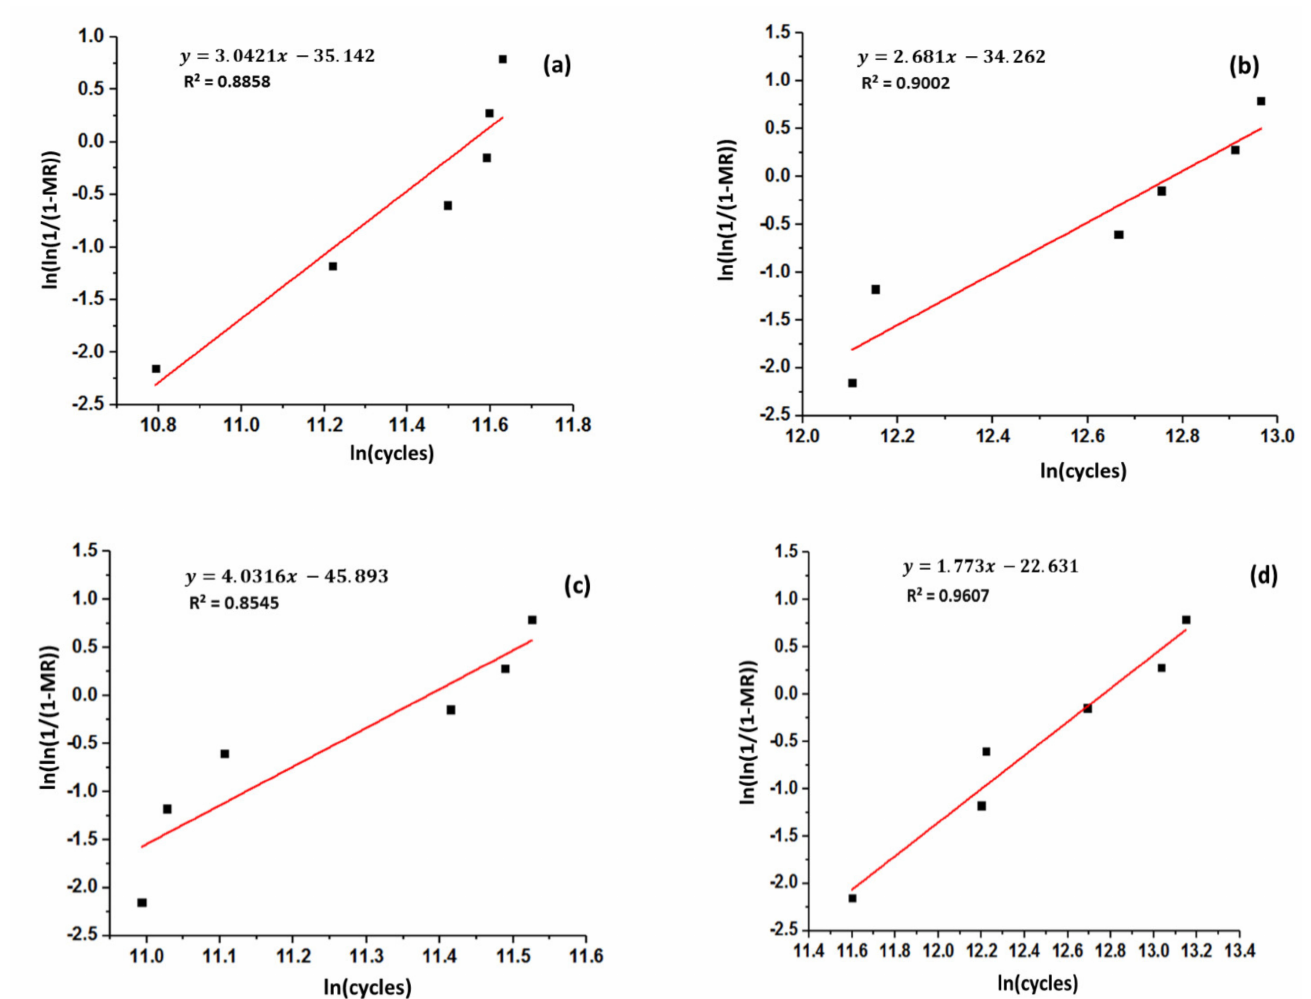
Figure 6. Weibull plots for ( a ) MO, ( b ) MO + PT, ( c ) MO + WS 2 and ( d ) MO+ MoS 2 . The survival probability curve is shown in Figure 7. It can be seen that MO containing PT and MoS 2 exhibited better survival probability compared to WS 2 -dispersed MO and MO without any additives. It is to be noted that even though MoS 2 initially showed a higher survival probability than PT-dispersed MO, at about 388,000 cycles the situation changed, and PT exhibited a better survival probability than MoS 2 . Furthermore, it was observed that the L 10 , L 50 and L 90 life of MoS 2 and PT-dispersed MO were higher than the MO and WS 2 -dispersed MO, indicating that usage of MoS 2 and PT enhanced the rolling contact fatigue life of the bearing balls, an important role being played by the